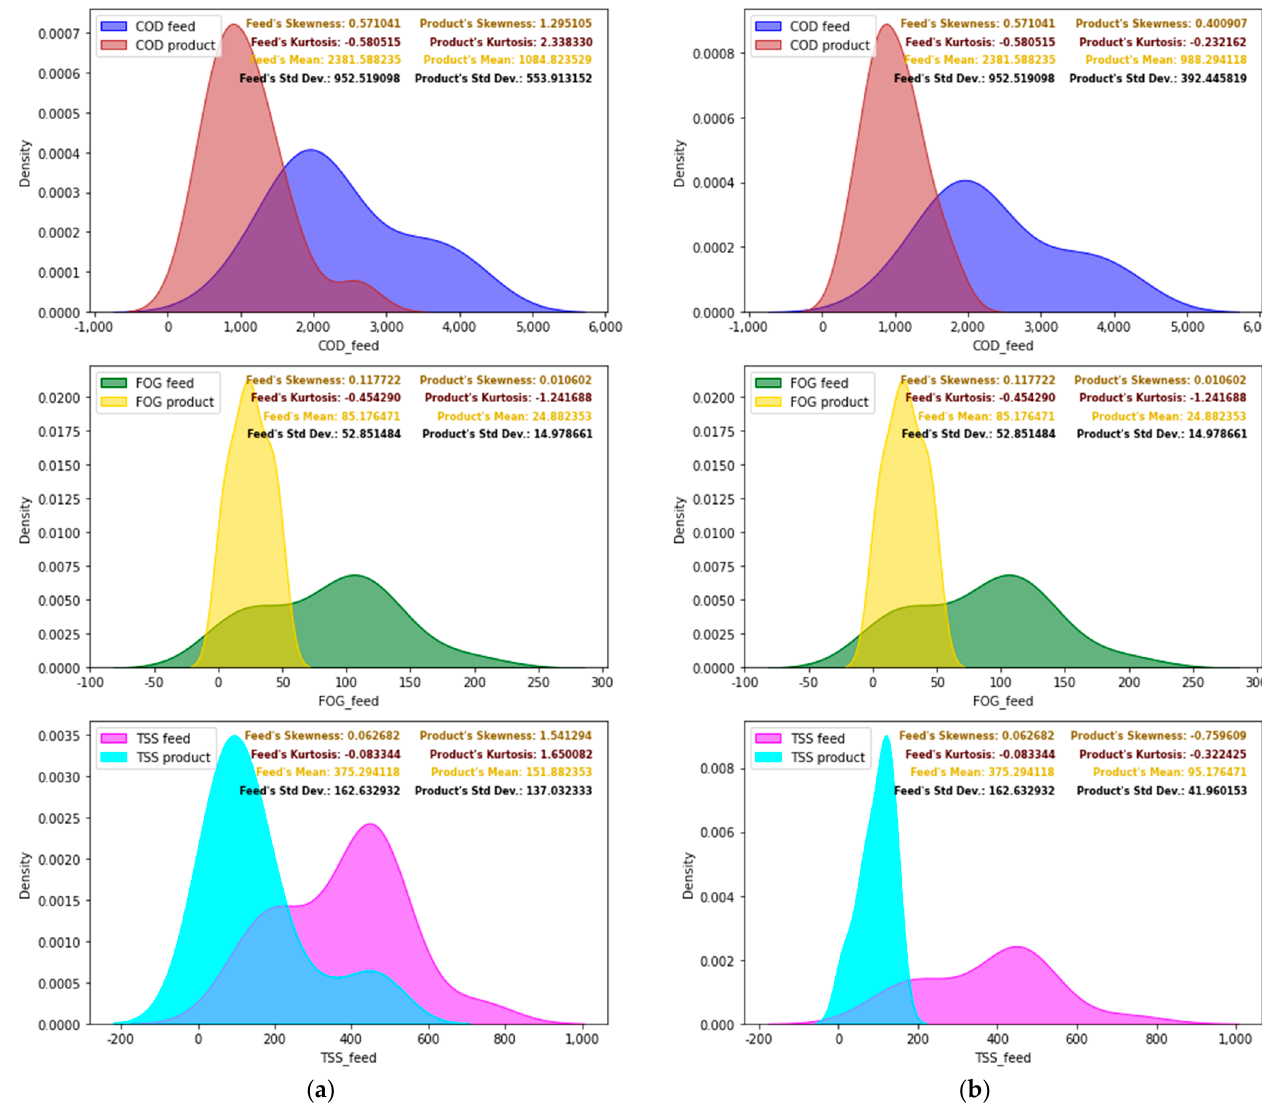
Figure 10. Probability density functions of the EGSB before and after anomaly detection and correction. ( a ) Before anomaly detection and correction. ( b ) After anomaly detection and correction.